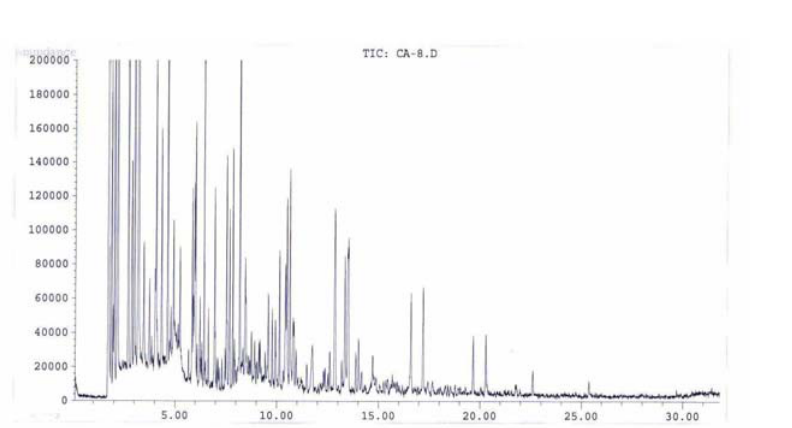
FIGURE 1 . Total ion chromatogram of an air sample collected in a canister, preconcentration volume 300